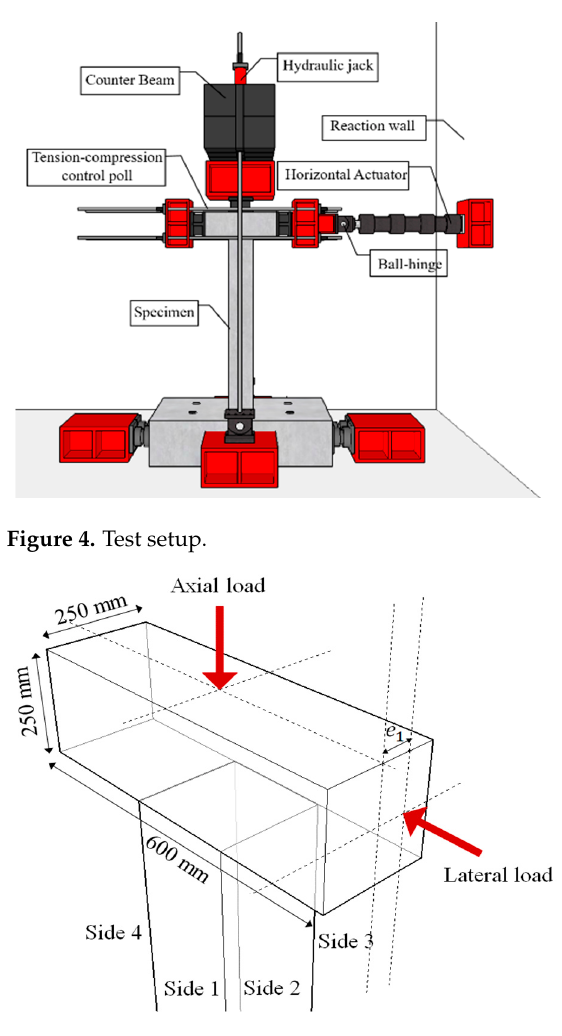
Figure 5. Loading method.